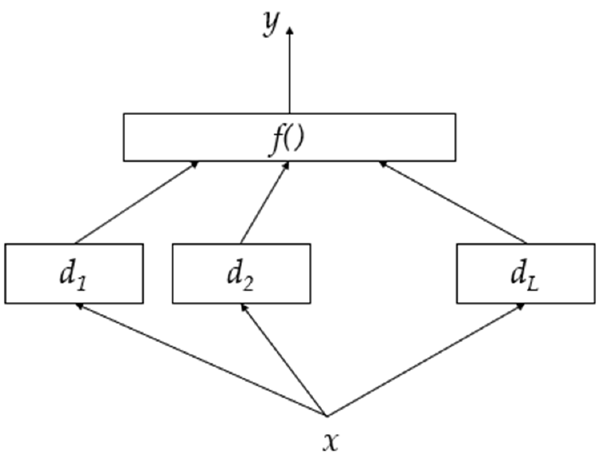
Figure 6. In stacking, the combiner is another learner. It is not limited to linear combinations such as voting [67]. voting [67].